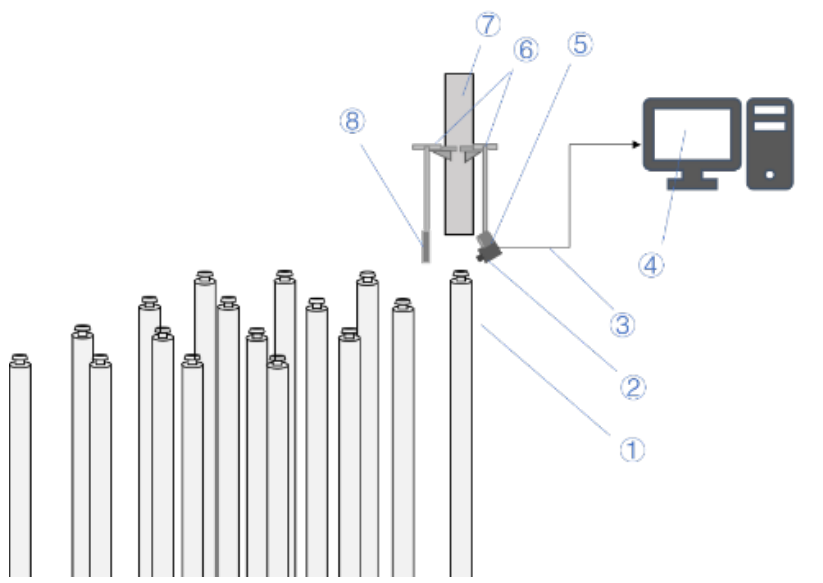
Figure 1. Schematic diagram of underwater photographing system. (1) drive rod, (2) underwater camera, (3) underwater cable, (4) camera controller, (5) underwater light source, (6) connecting long rod, (7) decoupling tool, and (8)